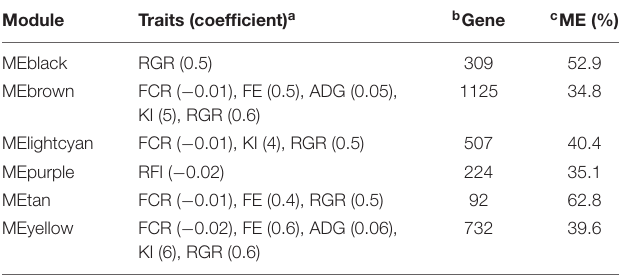
TABLE 2 | Description of significantly associated gene co-expression modules with feed efficiency-related traits in Nelore